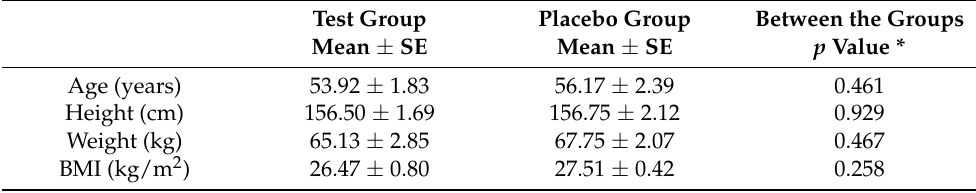
Table 1. Comparison of the baseline demographics of the test group and placebo